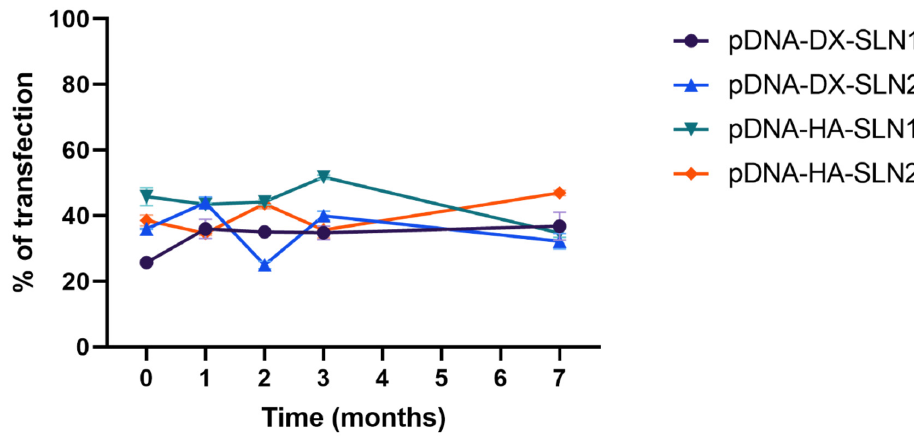
Figure 12. Percentage of ARPE-19 transfected cells after treatment with pDNA vectors after different times of storage. Data are expressed as mean ± standard deviation; n = 3.